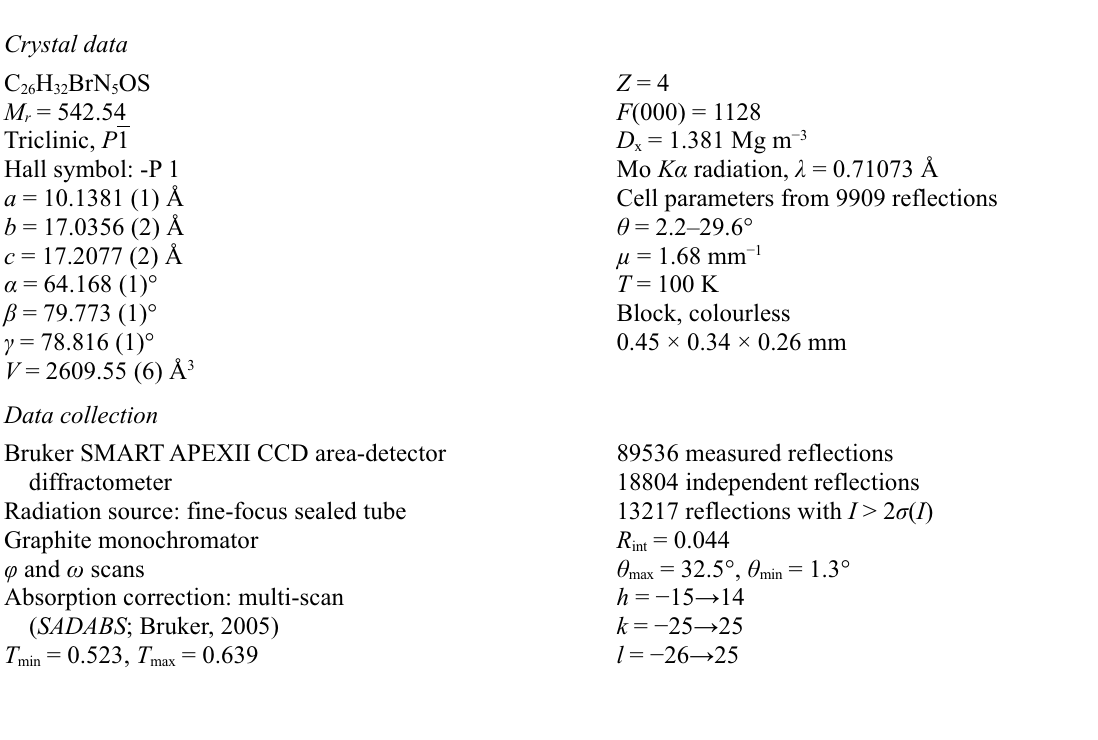
Figure 2 The crystal packing of the title compound, viewed along the a axis. Hydrogen bonds are shown as dashed lines.